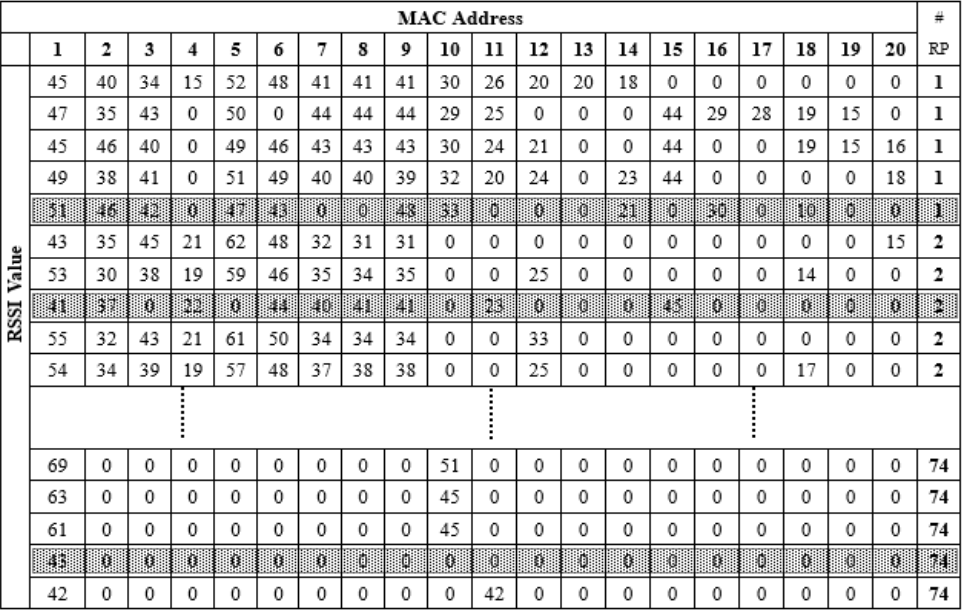
Figure 8. Clustering-based noise elimination scheme (CNES)-based training dataset with the high- lighted and deleted noise